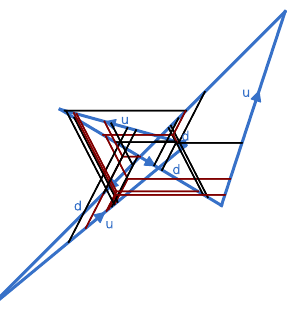
Figure 44 . A polygonal trefoil L in M = R 3 . Notation is as in figure 42. As before, we show all BPS strings which can attach to L ; in this case there are only exchanges and three-leaf webs.